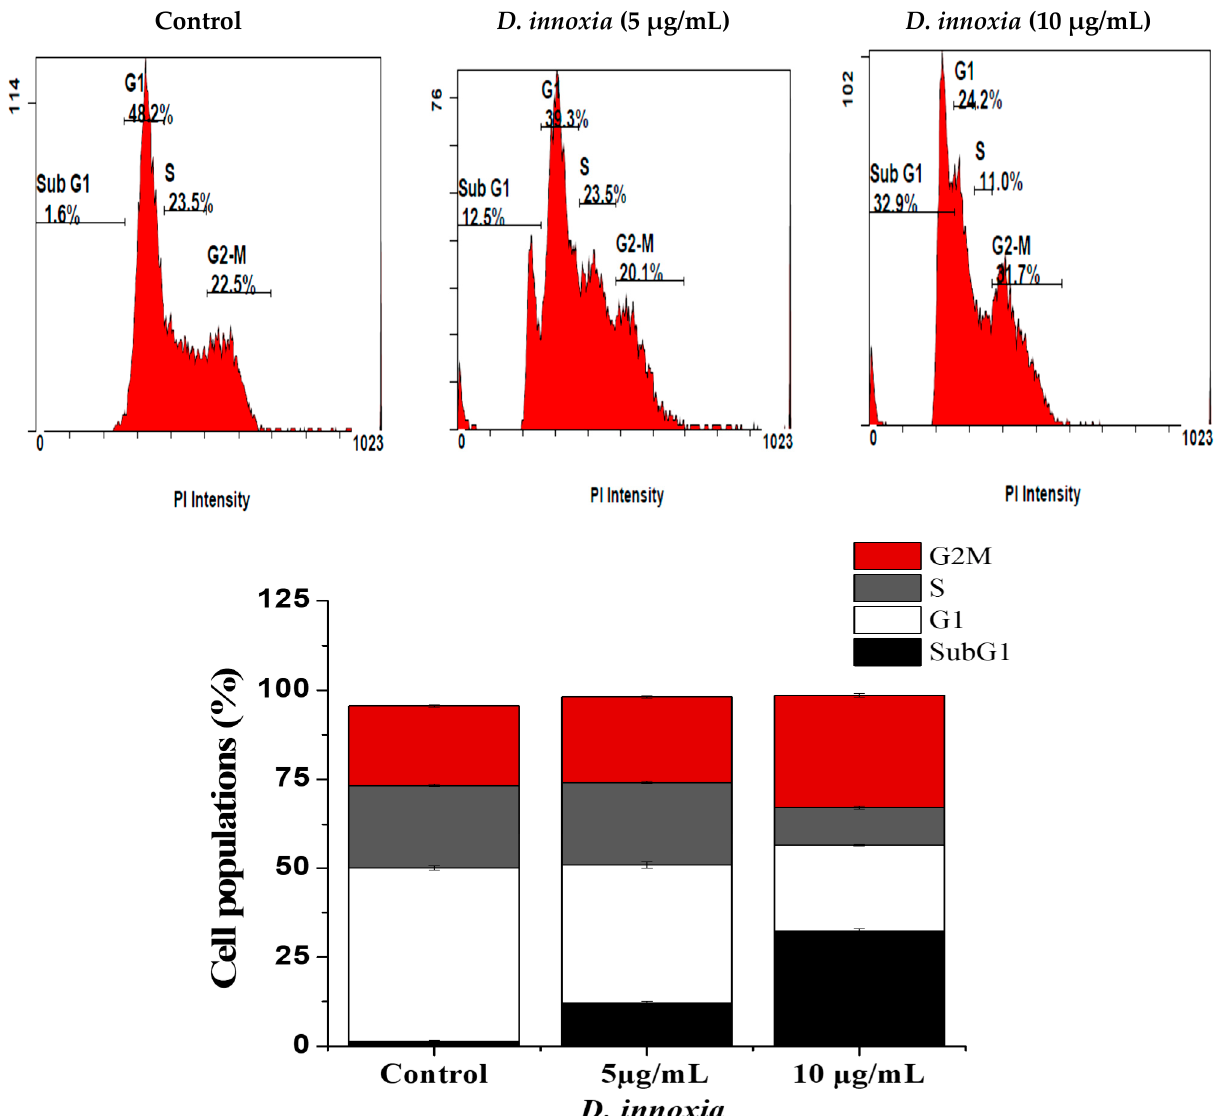
Figure 2. Histograms representing DNA contents analysis after 48 h of LoVo cells treatment. LoVo cells were treated with 5 and 10 µ g/mL D. innoxia and vehicle control. Cell cycle analysis was recorded on a Beckman Coulter Cytomics FC500 after PI staining.